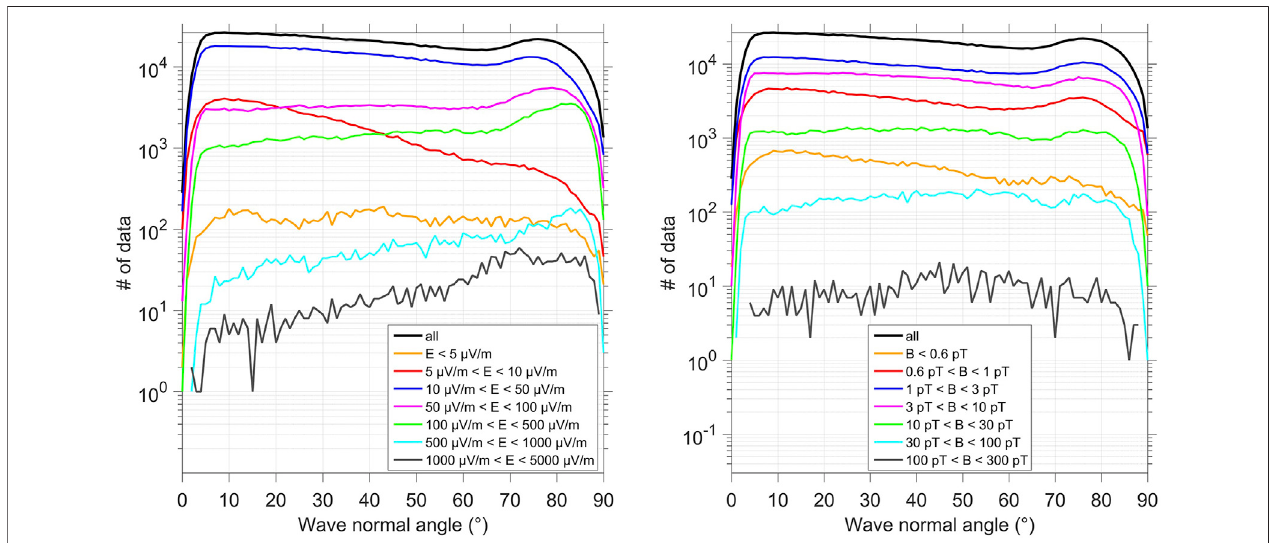
FIGURE5| Distribution(log10)ofwavenormalanglevaluessortedwithrespectto(left)theelectricamplitudeand(right)themagneticamplitudefordifferentbinsof amplitude.